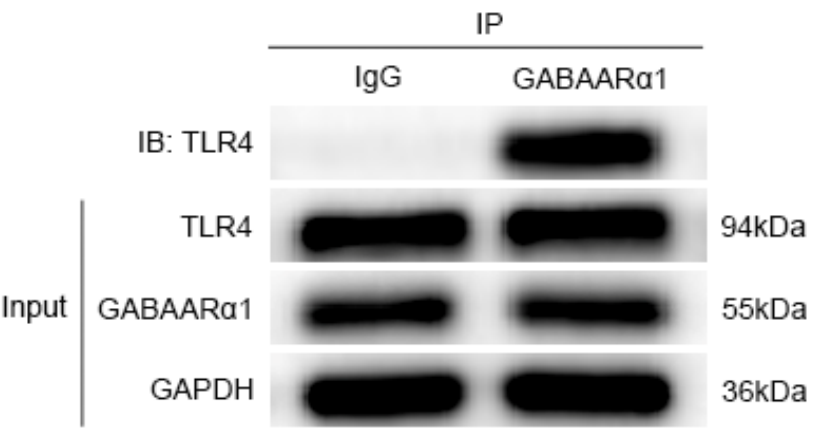
Figure 6. GABAAR α 1 binds TLR4 in the medullary dorsal horn of the epilepsy–migraine comorbidity. Figure 6. GABAARα 1 binds TLR4 in the medullary dorsal horn of the epilepsy – migraine comorbid- Protein extracts from the medullary dorsal horn tissue of the epilepsy–migraine comorbid rats were ity. Protein extracts from the medullary dorsal horn tissue of the epilepsy – migraine comorbid rats studied for TLR4/GABAAR α 1 co-immunoprecipitation (co-IP) with the GABAAR α 1 antibody or normal IgG (control), and the precipitates were immunoblotted with GABAAR α 1, TLR4, and GAPDH were studied for TLR4/GABAARα1 co -immunoprecipitation (co- IP) with the GABAARα1 an tibody antibodies. TLR4 was seen in the anti-GABAAR α 1 (but not normal IgG) precipitates from the protein or normal IgG (control), and the precipitates were immunoblotted with GABAARα1, TLR4, and extracts, indicative of protein–protein GAPDH antibodies. TLR4 was seen in the anti- GABAARα1 (but not normal IgG) precipitates from the protein extracts, indicative of protein – protein interaction.